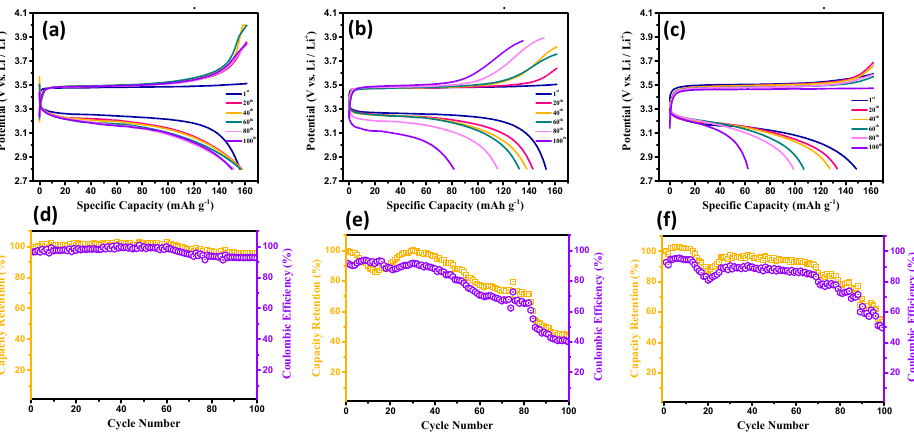
Figure 4. Typical charge–discharge curves and cyclic performance of the test cells equipped with different CSEs, where the LiTFSI/LATP ratios were 1.5 ( a , d ), 1.8 ( b , e ), and 2.0 ( c , f ). Next, the influence of CSE thickness on the electrochemical performance of the lith- ium-ion batteries with Li-metal anodes was explored, as shown in Figure 5. The thick- nesses of the CSE films on the LFP cathodes were controlled at 40, 70, and 100 μ m. The Li- metal batteries were cyclically charged and discharged for 100 cycles at 0.5 C at an ambient temperature. According to Figure 5, the reduced CSE thickness resulted in the improved cyclic performance of the coin cells. Compared to other configurations, the Li-metal bat- teries equipped with 40 μ m-thick CSE films displayed the best cyclic stability (i.e., the capacity retention was ~96.3%) and a remarkable coulombic efficiency (~92.5%) after 100 cycles. Indeed, reducing the CSE thickness reduced the ohmic polarization. In contrast, thicker CSE layers imparted longer diffusion pathways for the Li + ions. In particular, at higher C-rate operations, an increased ohmic polarization may result in the poor cyclic performance of Li-metal batteries during long-duration cycling.